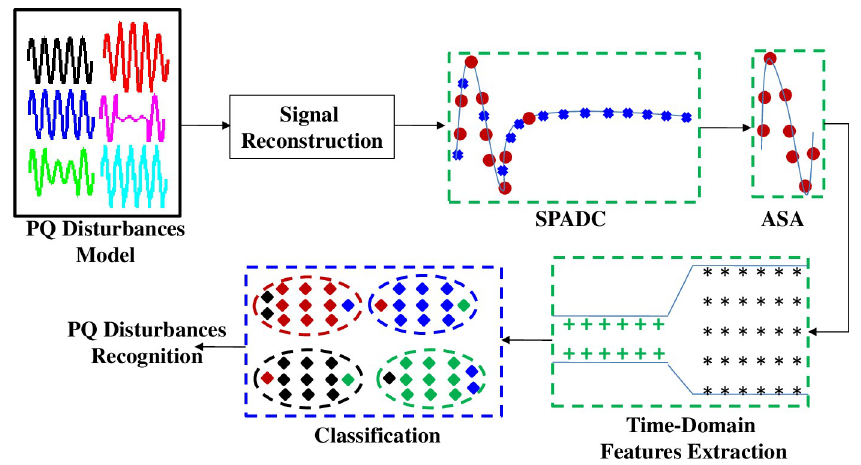
Fig 1. The suggested system block